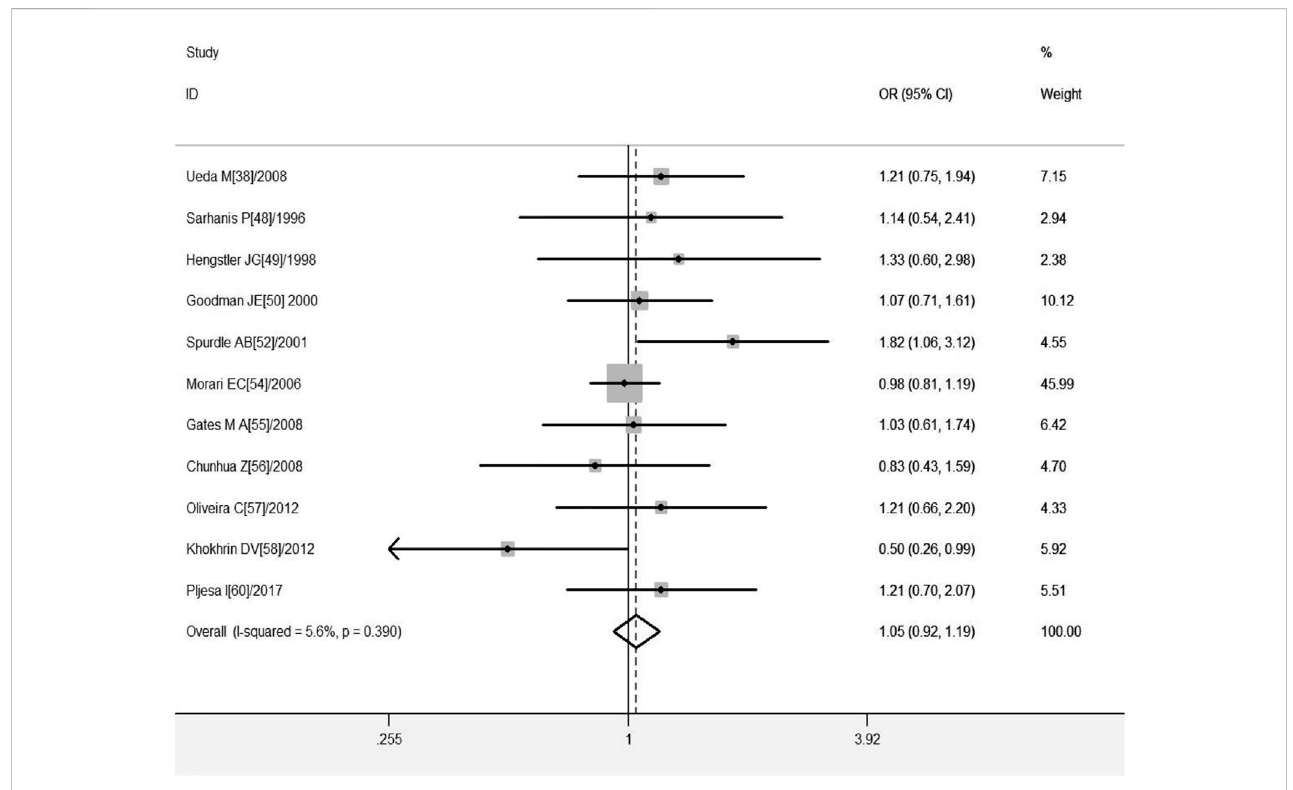
FIGURE 5 Forest plot of meta-analysis of the relationship between GSTT1 gene polymorphisms and ovarian cancer